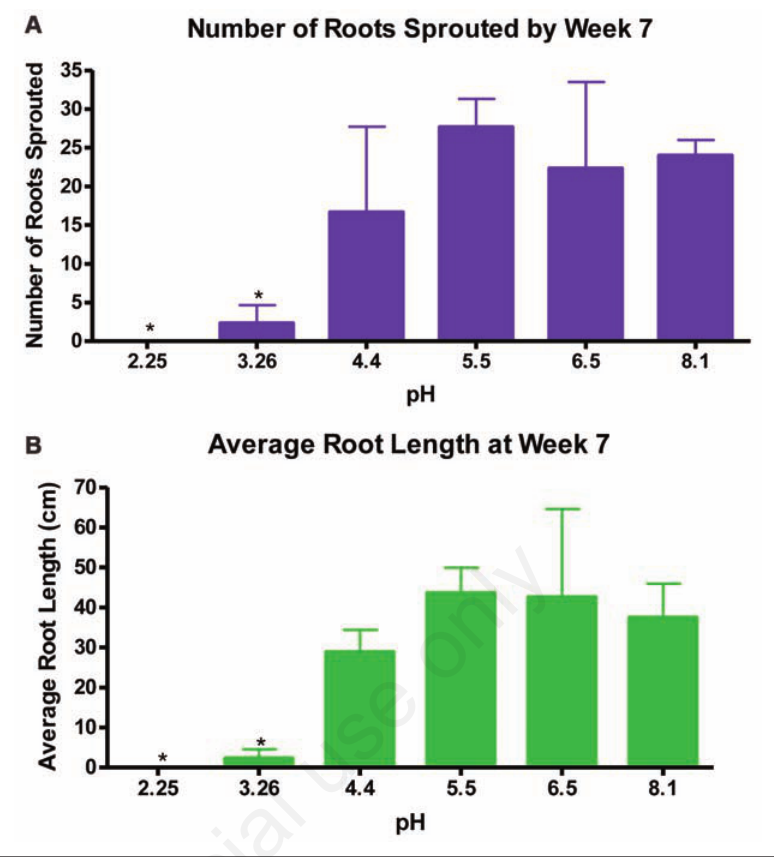
Figure 1. A) The average number of roots sprouted by cuttings of S. aureus cuttings as a function of the pH of the water after 7 weeks. B) The average cumulative root length of S. aureus cuttings as a function of the pH of the water after 7 weeks. *P<0.05 versus all other pH except 2.25 and